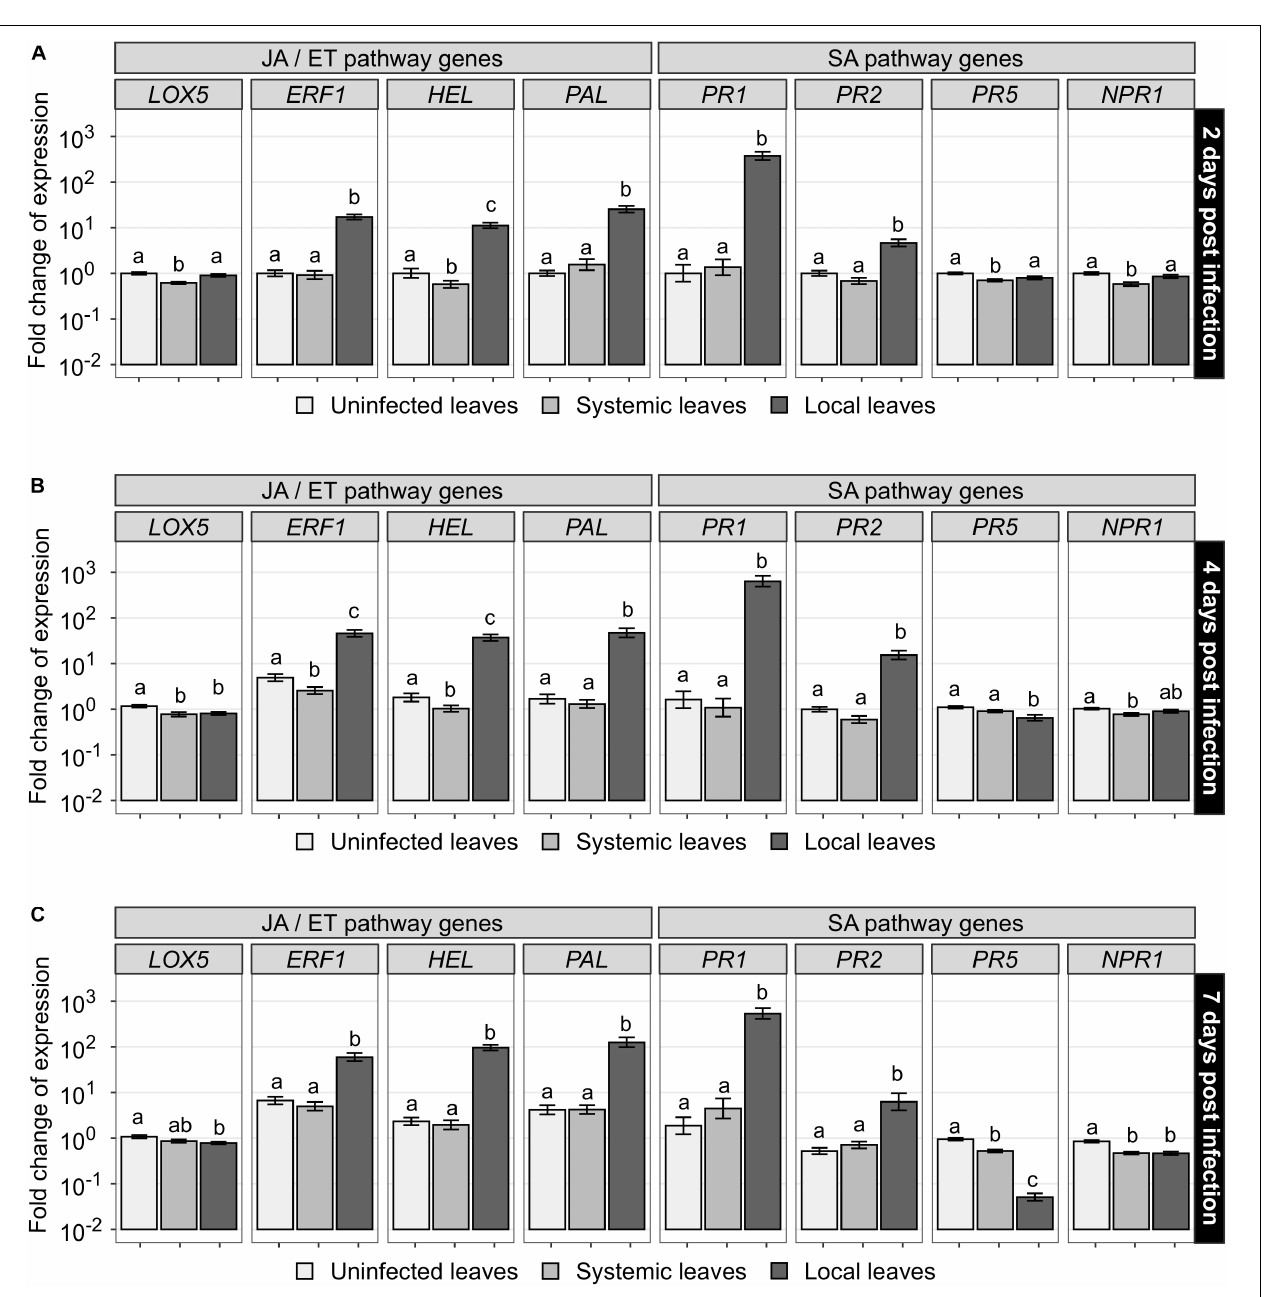
FIGURE 4 | Effects of B. cinerea treatment on the expression of putative JA/ET- and SA-mediated genes at different harvest times in cannabis leaves. Fourteen-day-old cannabis plants were infected with B. cinerea (diseased plants) or left untreated (uninfected plants). Leaf tissues were sampled after (A) 2 days, (B) 4 days, and (C) 7 days. Total RNA was extracted and the expression level of eight putative defense genes was analyzed by RT-qPCR in uninfected plants (uninfected leaves, white) and diseased plants (systemic leaves remote from infection site, light gray, and local infected leaves, dark gray). Fold changes of expression were scaled per gene relatively to the average expression in uninfected leaves at 2 days after infection (expression level of 1). Means and standard errors of 36 independent biological replicates and 3 technical replicates are displayed on a log 10 scale. Treatments sharing the same letter are not significantly different according to Wald chi-square test with Benjamini-Hochberg correction, α =